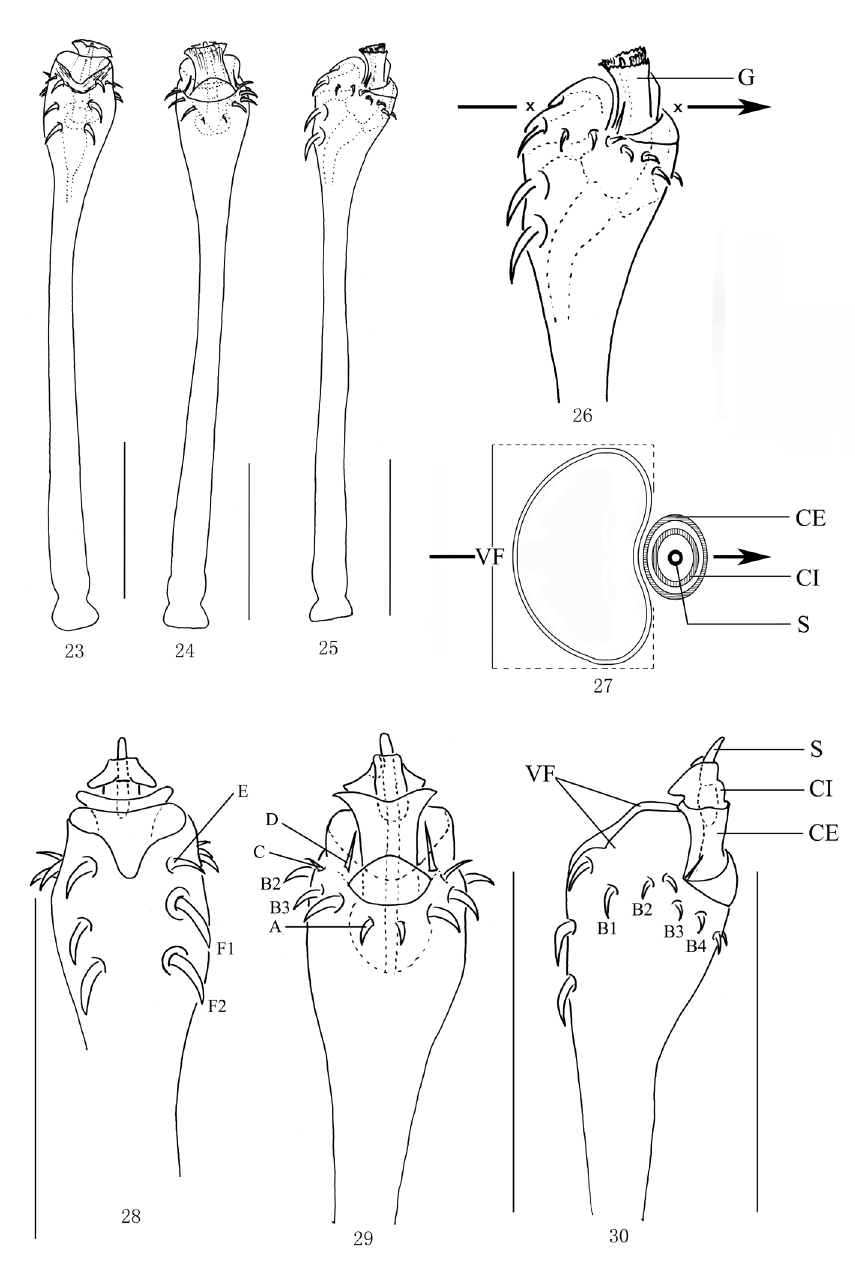
Figures 23–30. Lobonychium palpiplus Roewer, 1938 (MHBU-Opi-20151208m) 23 Penis, ventral view 24 Same, dorsal view 25 Same, lateral view 26 Distal part of penis, lateral view 27 cross-section through glans and truncus at the marked point 28 Distal part of penis (expanded), ventral view 29 Same, dorsal view 30 Same, lateral view. Abbreviations: CE capsula externa (follis) CI capsula interna G glans S stylus VF ventral frame. Scale bars: 0.25